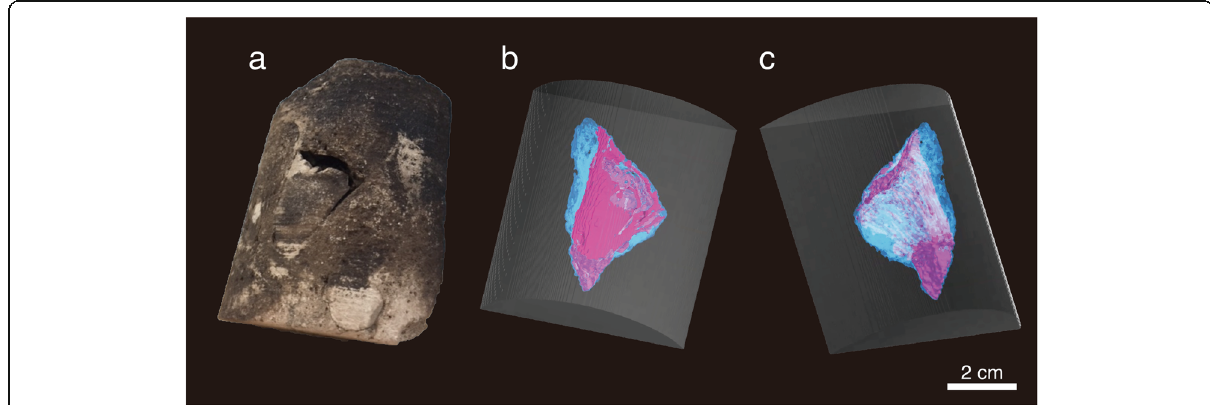
Fig. 7 Three-dimensional modeling of rudist B. a External surface of the studied core seen diagonally from the bottom right. b , c 3D model of rudist B seen from the external core surface ( b ) and the split core surface ( c ). Magenta and cyan colors indicate the inner and outer shell layers,